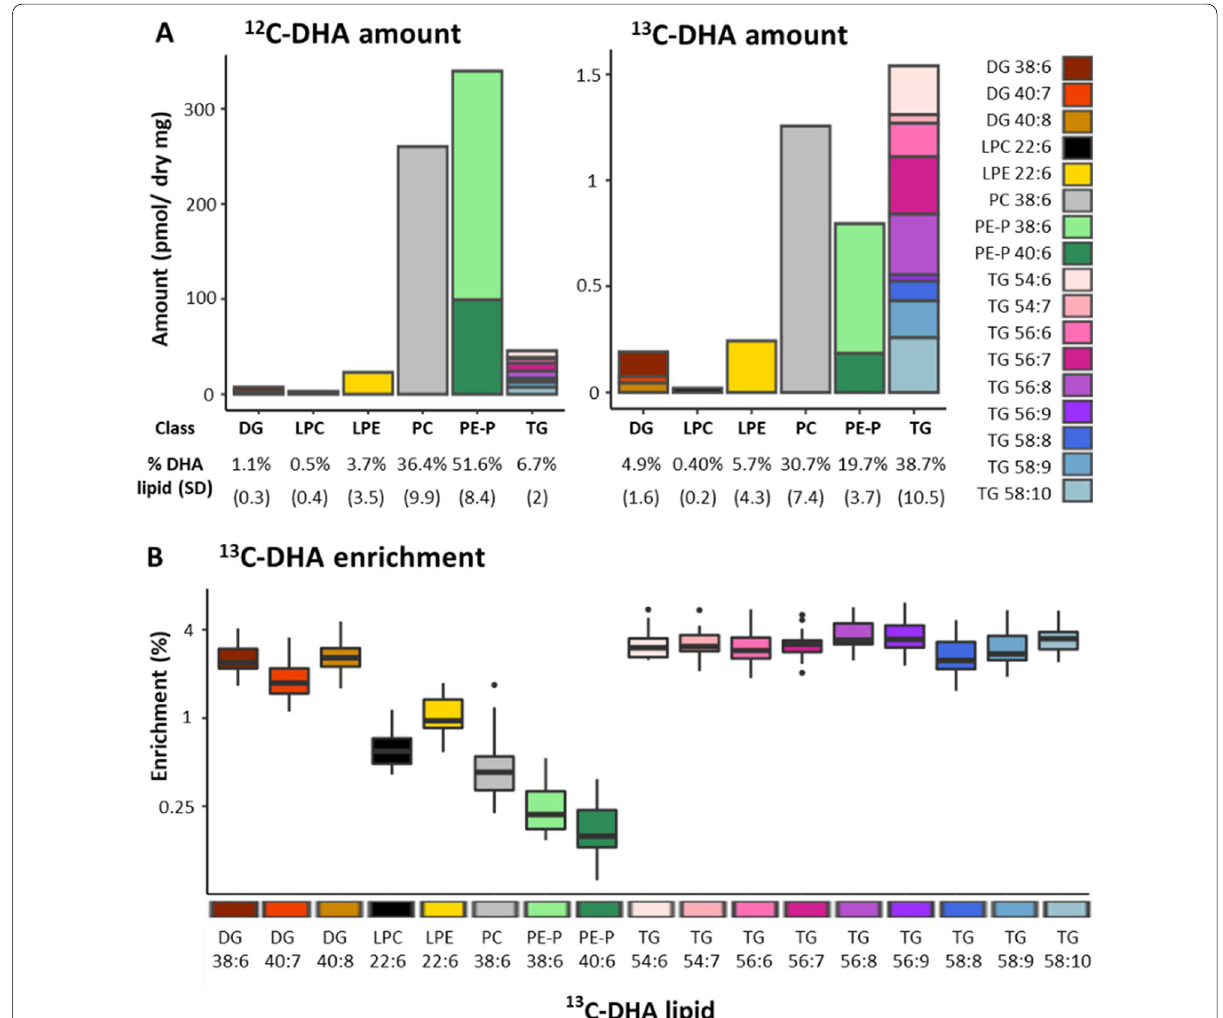
Fig. 1 Placental lipids containing 12 C‑DHA and 13 C‑DHA in placental explants from 17 placenta incubated for 48 h with 24 µmol/L 13 C‑DHA at a physiological glucose concentration (5 mmol/L). A Amount of each lipid (pmol/mg) with percentages showing relative amount of each lipid class compared to total 12 C‑DHA or 13 C‑DHA lipids. Brackets show standard deviation. Colours represent individual lipids. B Boxplots showing the enrichment of each lipid with 13 C‑DHA. Enrichment is the percentage of each lipid containing 13 C‑DHA calculated by the formula 100 * 13 C‑lipid/ 12 C‑lipid). DHA docosahexaenoic acid, DG diacylglycerol, LPC lyso‑phosphatidylcholine, LPE lyso‑phosphatidylethanolamine, PC ( 13 C‑lipid + phosphatidylcholine, PE-P phosphatidylethanolamine‑plasmalogen, TG triacylglycerols. Labeled TGs contained 13 C‑DHA and two other fatty acids which cannot be identified with certainty. Since the total number of fatty acid carbons ( x ) and the total number of fatty acid double bonds ( y ) is known for each TG (format x:y ), the combined carbon count and saturation of the two remaining fatty acids can be calculated, then predicted based on known abundance in humans. Two TGs contained 13 C‑DHA and two saturated lipids (TG 54:6 [predicted 16:0_16:0_22:6], TG 56:6